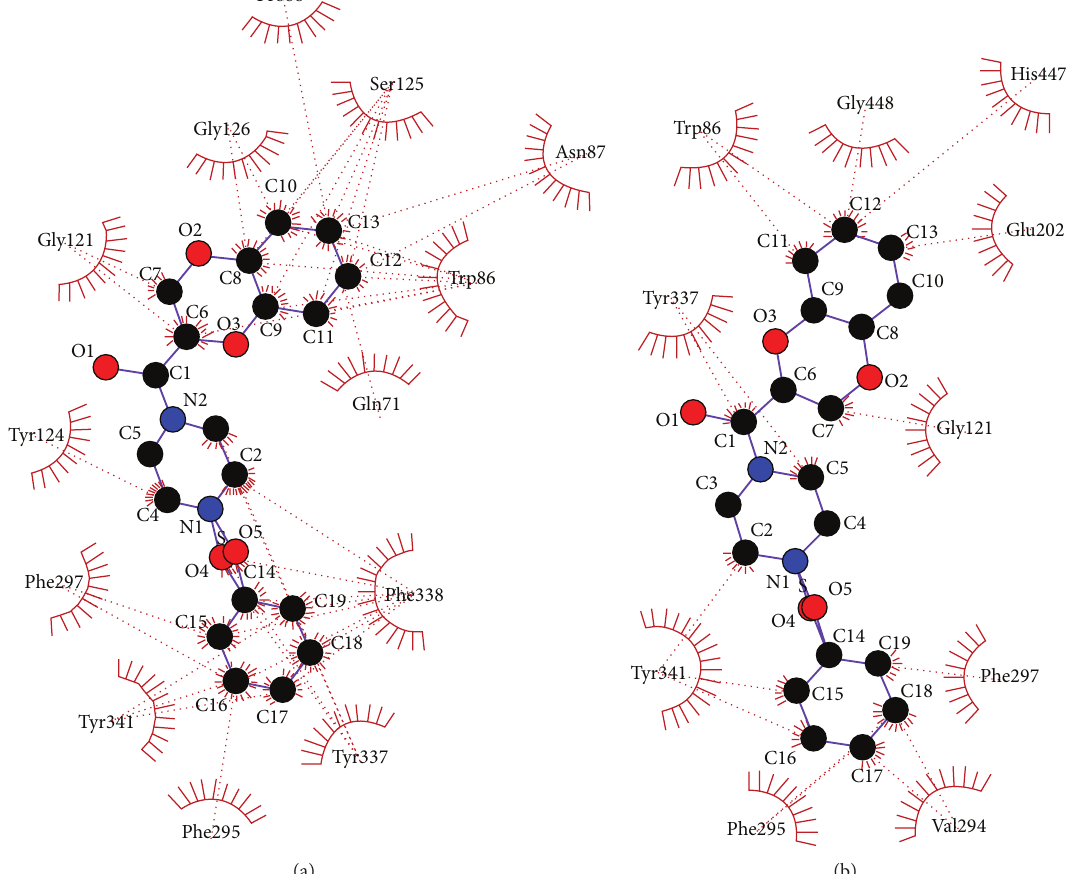
Figure7:(a)Catalyticsitedockingof4-benzenesulfonyl-1-(1,4-benzodioxane-2-carbonyl)piperazine(S4).(b)Peripheralanionicsitedocking of 4-benzenesulfonyl-1-(1,4-benzodioxane-2-carbonyl) piperazine